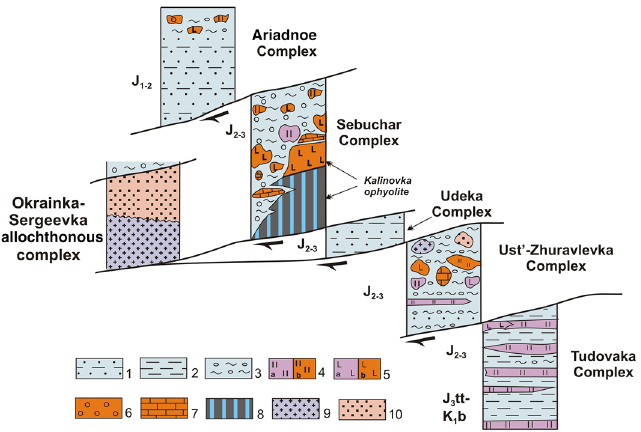
Figure 8. Relationships of tectonostratigraphic complexes in the southern part of the Samarka Terrane, a fragment of the Jurassic accretionary prism. 1–3 – matrix of accretionary prism: 1 – sandstones, siltstone,